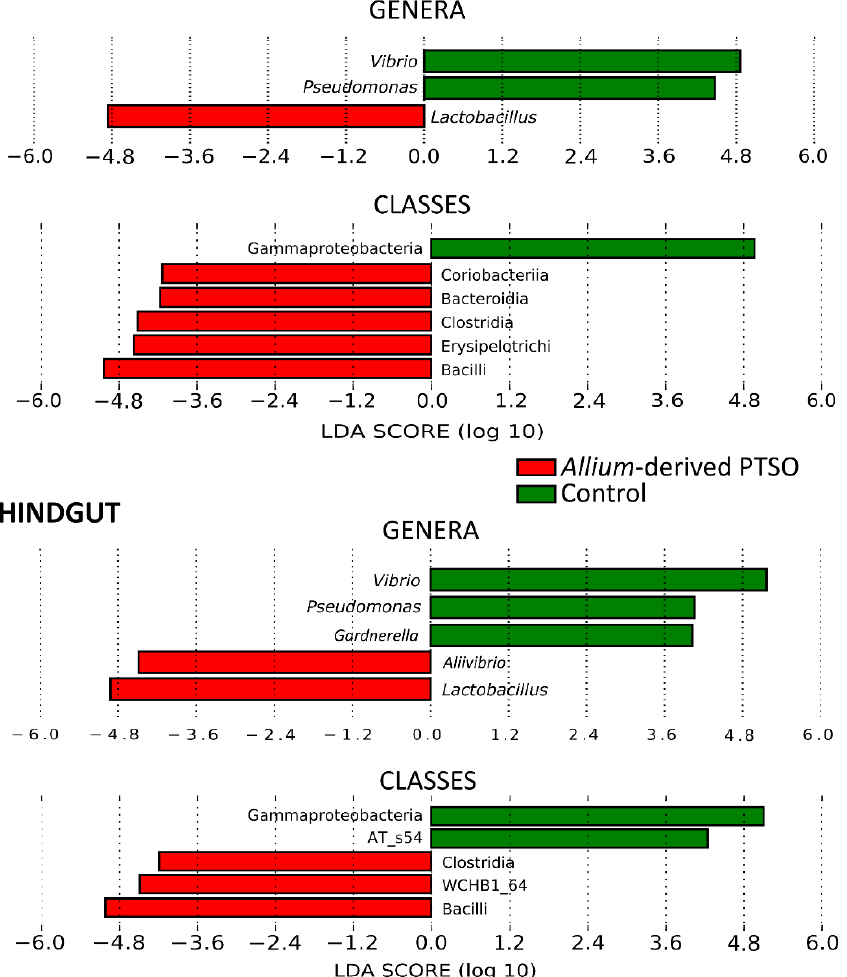
Figure 1. LDA effect size (LEfSe) analyses showing bacterial classes and genera that differed significantly between control fish and those supplemented with Allium -derived PTSO in the foregut and hindgut. Significant LDA score > 4.0. Sample size was 48 for control foregut, 55 for control hindgut, 42 for Allium -supplemented foregut, and 51 for Allium-supplemented hindgut.